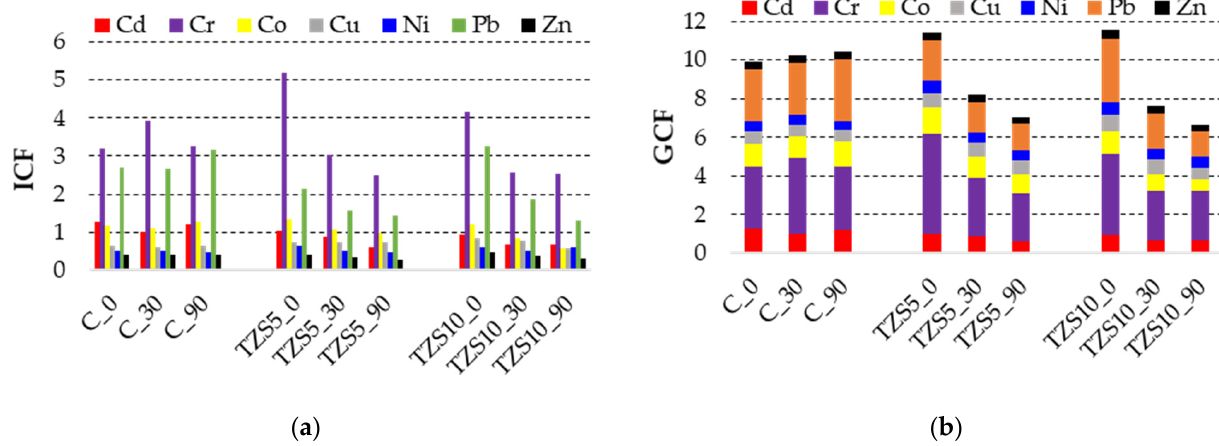
Figure 3. ( a ) Individual contamination factor (ICF) and ( b ) global contamination factor (GCF) of potentially toxic elements in the control soil (C) and soil amended with 5% (TZS5) and 10% (TZS10) zeolite at 0, 30, and 90 days after